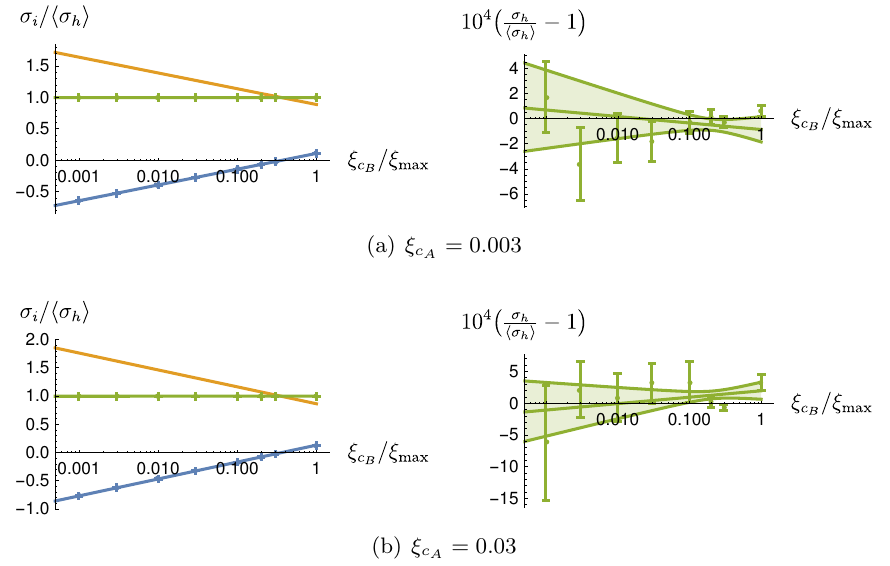
Figure 1 . (cid:24) c (in)dependence of the ( (cid:15) 0 coe(cid:14)cient of the) real-virtual contribution, for two values B of (cid:24) c . The blue dots show the d (cid:27) (2) contribution with a (cid:12)t (blue line). The orange line corresponds f A to d (cid:27) (2)